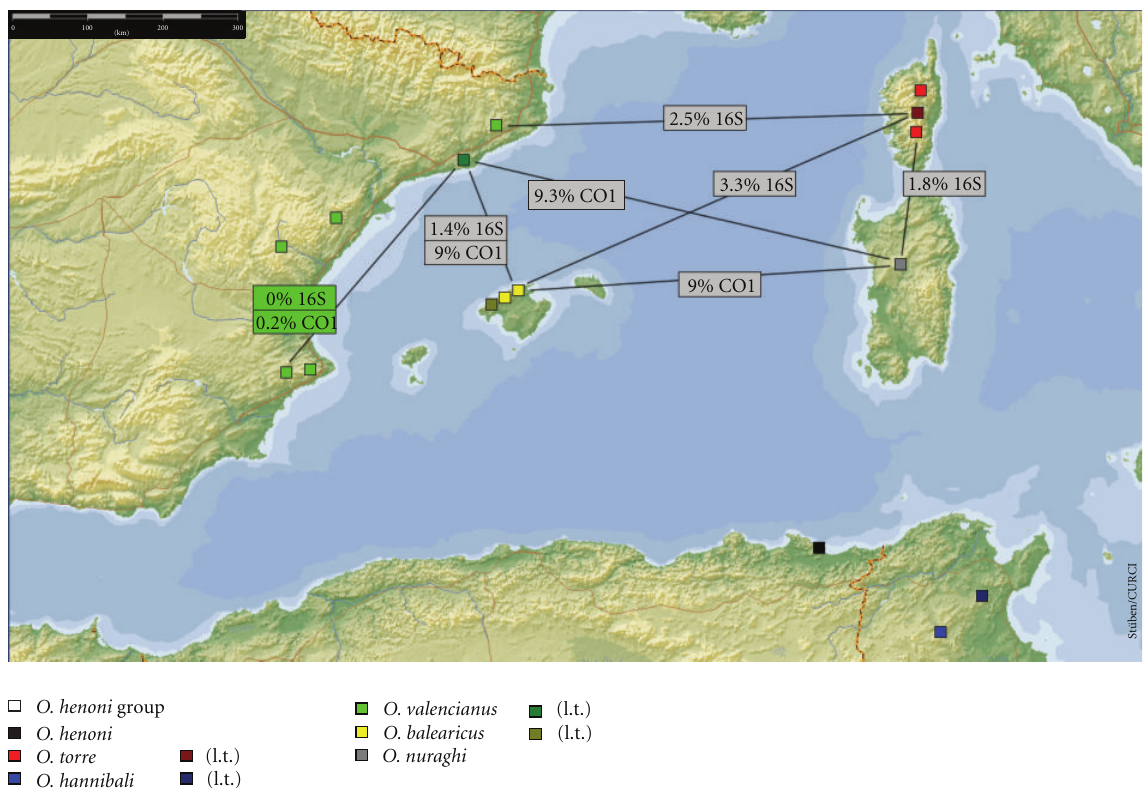
Figure 2: Distribution of related species of the West Mediterranean species of the O. henoni group (without O. croaticus, Eastern Europe) with values of COI and 16S